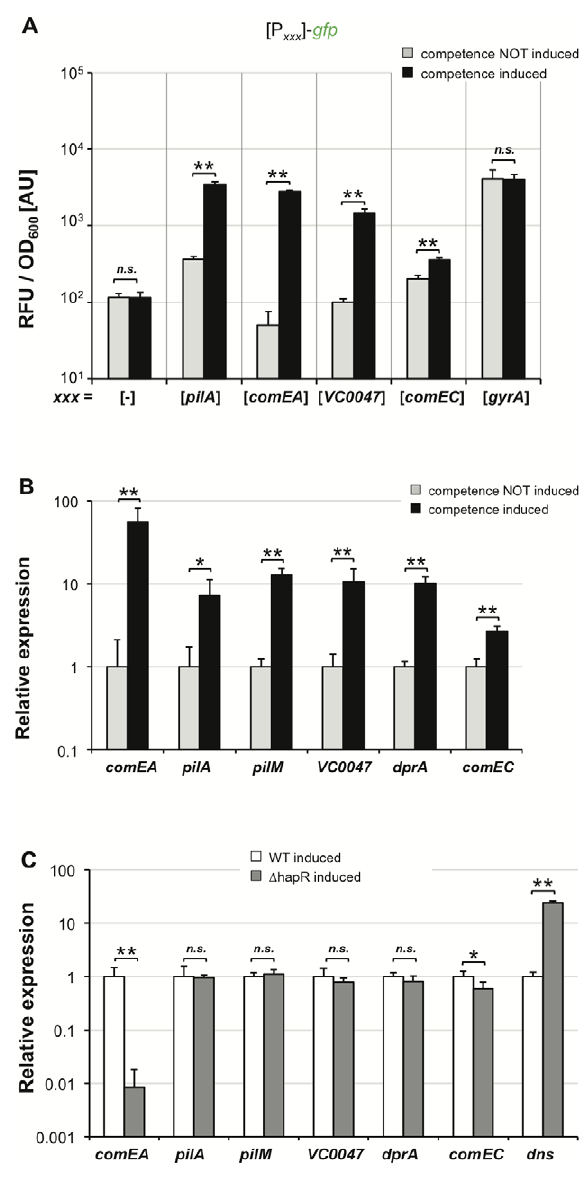
Figure 6. TfoX drives expression of QS–dependent and QS– independent competence genes. V. cholerae wild type strain containing artificially inducible tfoX in cis was tested for the expression of different competence genes. Panel A: Different transcriptional FP reporter fusions were tested for TfoX-dependent induction. These fusions were composed of the potential promoter region of the respective competence gene(s) (x-axis) fused to gfp . The housekeeping gene gyrA was tested as control. Relative fluorescence per OD 600 unit is given on the y-axis. Panel B and C: qRT-PCR data comparing the relative expression of the indicated genes in a wild type strain under competence non-inducing and competence-inducing conditions (panel B). In panel C both the wild type strain and the hapR mutant were tested for competence gene expression under tfoX -expressing condi- tions. All panels depict averages of at least three independent experiments and error bars indicate standard deviations. Statistically significant differences were determined using Student’s t tests. * P , 0.05, ** P , 0.01, n.s. =not significant.